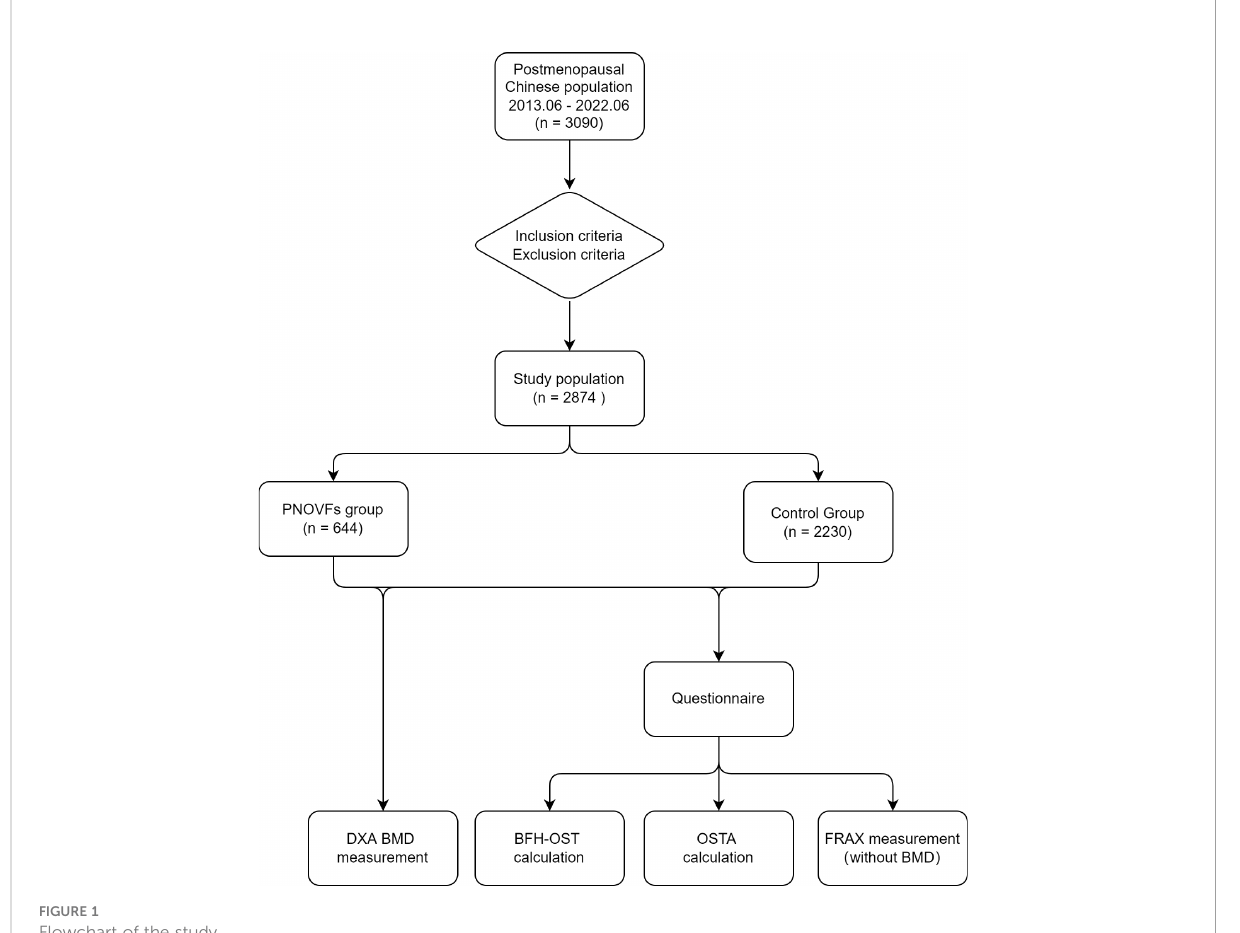
FIGURE 1 Flowchart of the